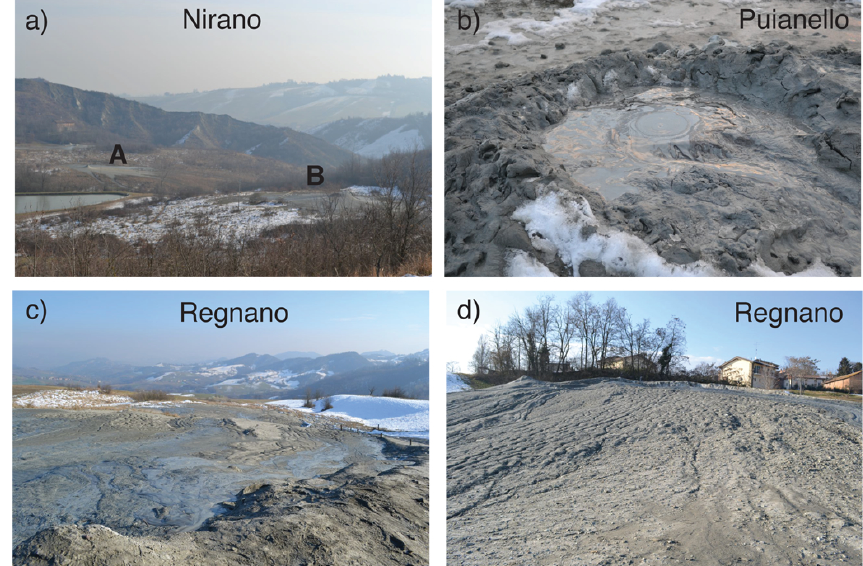
Fig. 2. Photos of the Pede-Apennine mud volcanoes (26 January 2011): (a) Nirano, showing vents A and B; (b) Puianello; (c) Regnano looking downhill; (d) Regnano looking uphill.